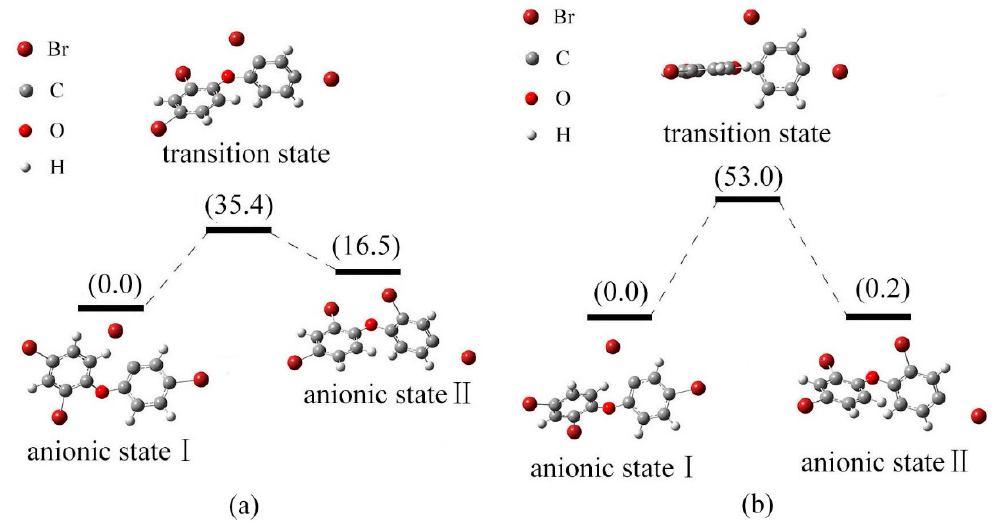
Figure 9. Relative energy of three possible anionic states and the transition states between them for BDE-47 (kJ/mol). (( a ) in gas phase; ( b ) in solution). BDE-47 (kJ/mol). (( a ) in gas phase; ( b ) in